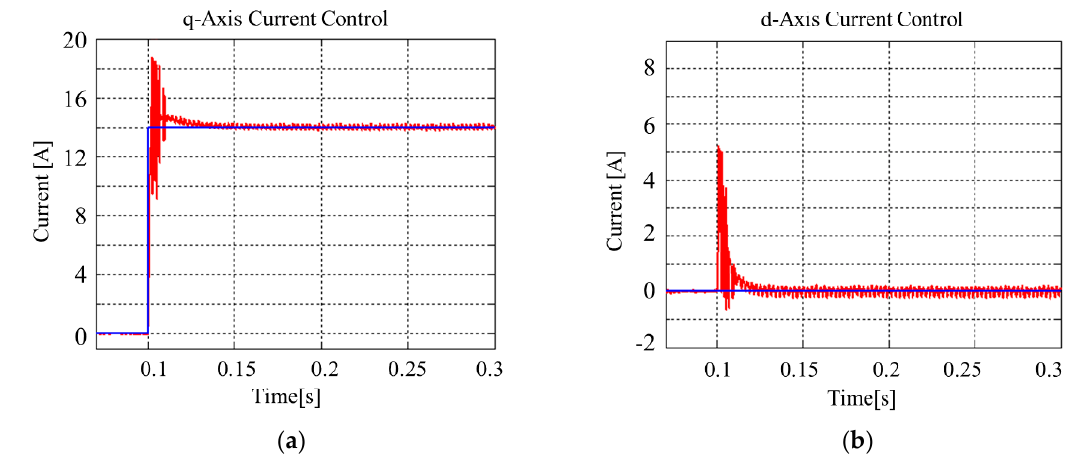
Figure 8. Simulation result of current control without MTPA: ( a ) q-axis and ( b ) d-axis.